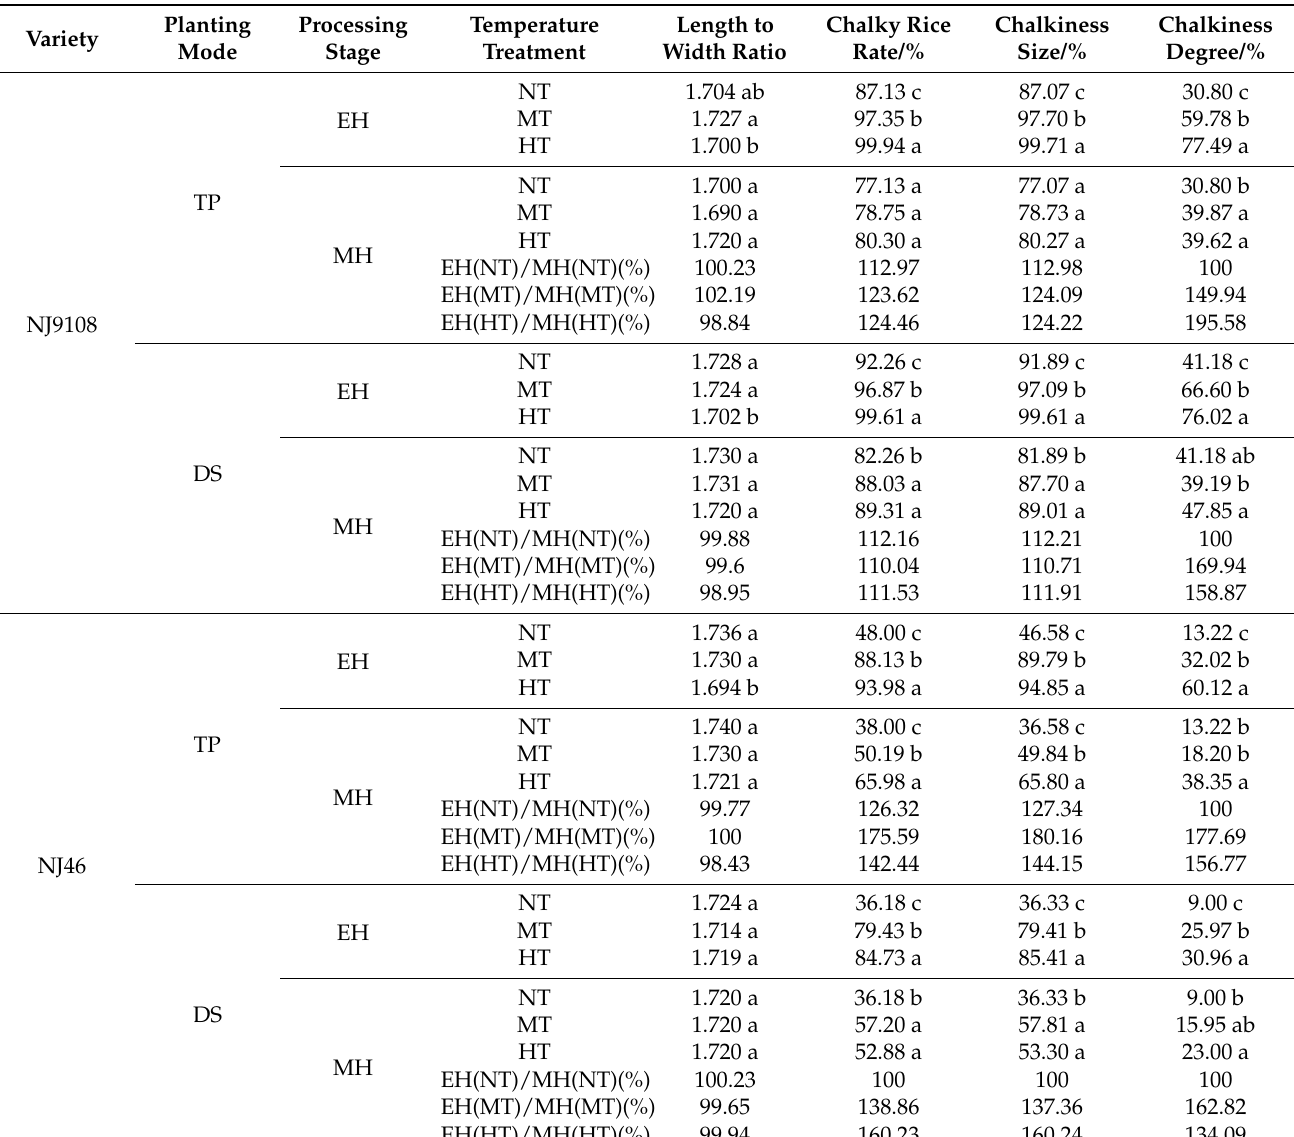
Table 4. Effects of high temperature on appearance quality of japonica rice in early and middle heading stage under transplanting and direct